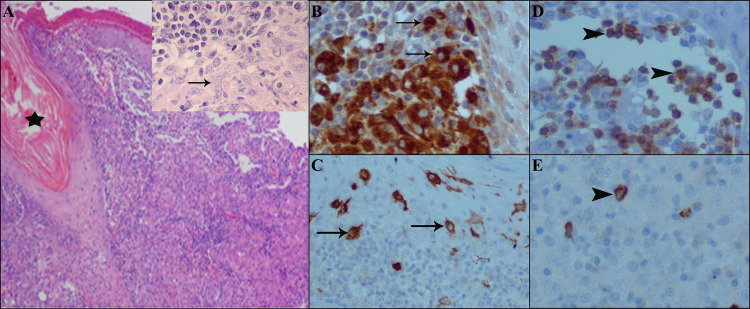
Histopathology and immunohistochemical findings in responsive form.A) H & E staining shows follicular plugging (star) and acanthosis, dermis displaying dense histiocytic and lymphocytic infiltrate (empty square and arrow) and many intracytoplasmic Leishman bodies, B) aggregation of histiocytes by CD68 IHC staining (arrows), C) collection of Langerhans cells in epidermis mostly, and dispersedly upper dermis by CD1a (arrows), D) CD3 lymphocytes infiltrate between histiocytes (arrowheads), E) rarity of positive B lymphocytes by CD20 IHC staining (arrowhead).